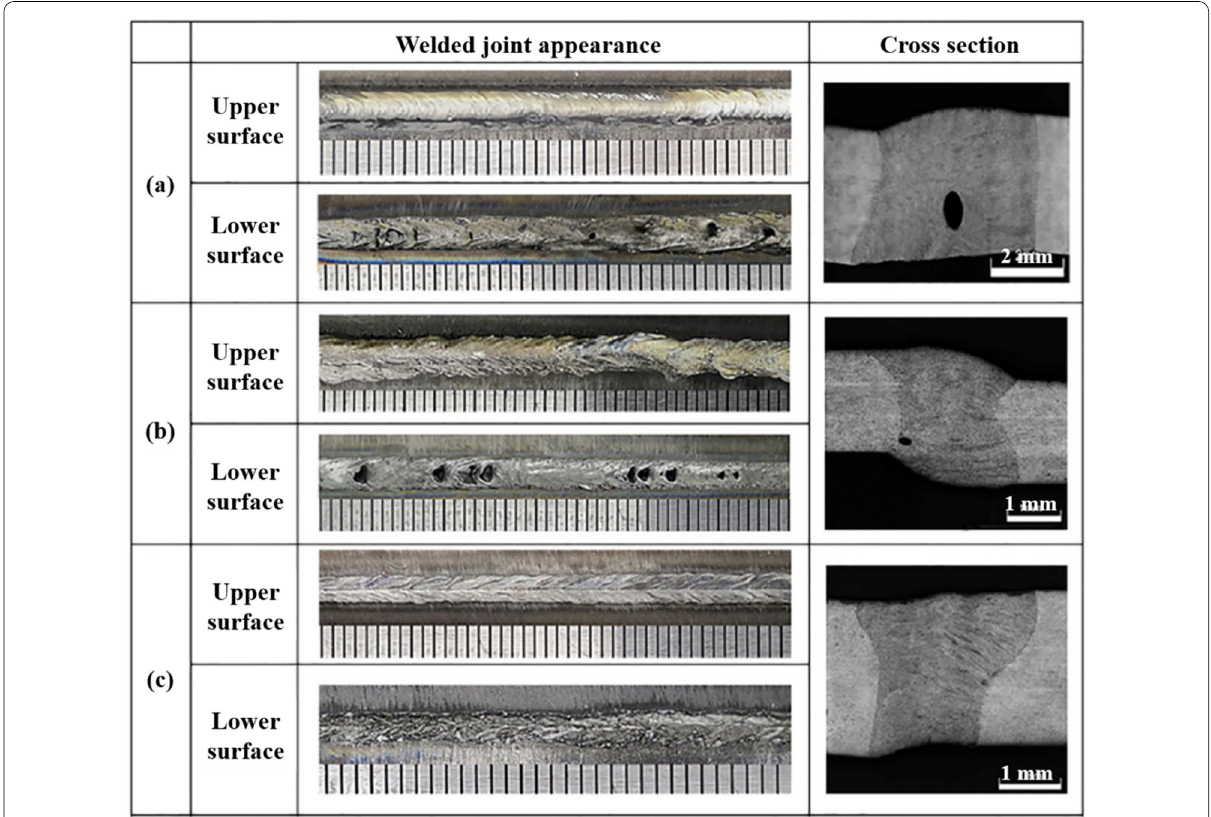
Figure 12 Welded joint appearance and cross section of butt joints of 304 stainless steel at different welding speeds: ( a ) 0.6 m/min, ( b ) 0.8 m/min, ( c ) 1.0 m/min